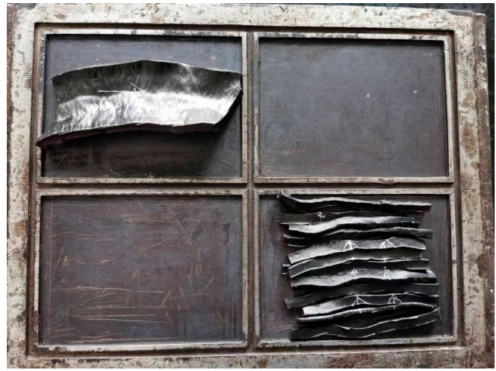
Figure 10. Samples for S and V (cid:48) tests in the mold. Performance